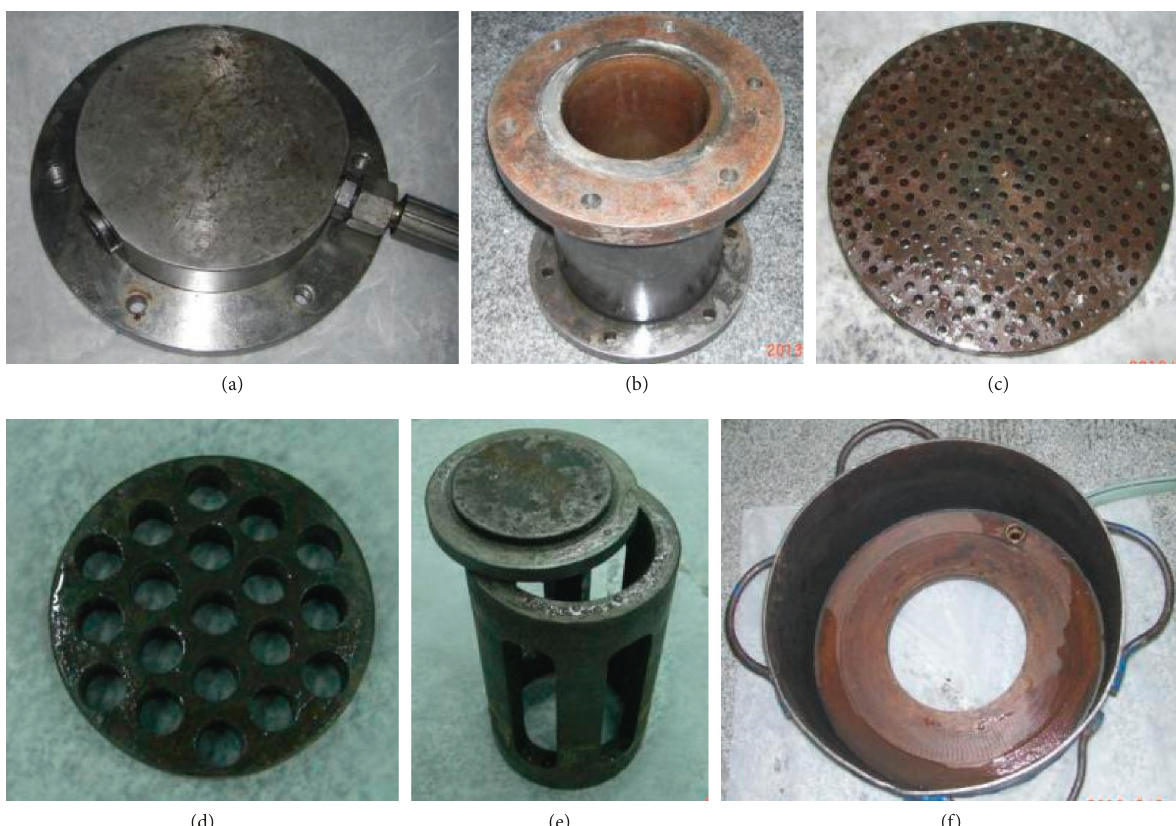
Figure 4: Permeameter. (a) Floor, (b) cylinder, (c) permeable plate, (d) piston, (e) overflow tank, and (f) lost fine particles-collecting tank.